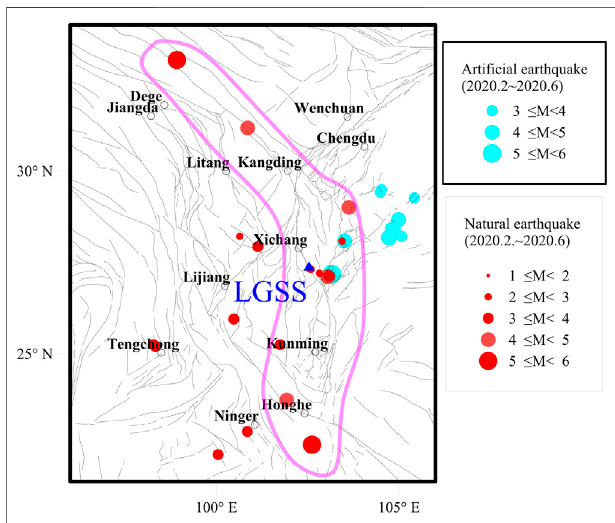
FIGURE8| Locationofnaturalandarti fi cialearthquakeduringtheperiod of monitoring.